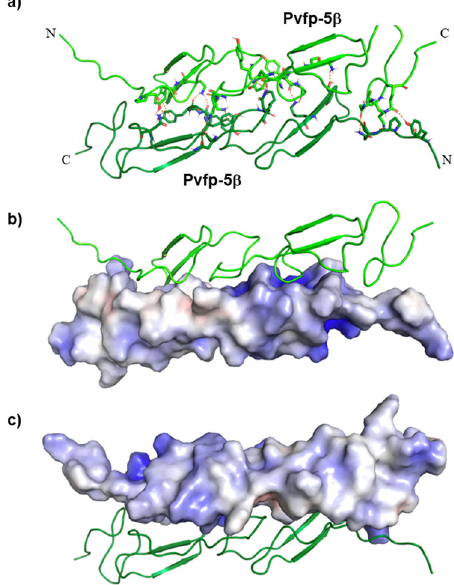
Fig. 4 HADDOCK model of Pvfp-5 β dimer. Lowest energy structure of Pvfp-5 β /Pvfp-5 β dimer as calculated by HADDOCK. a cartoon representation with residues of the two components involved in the interaction showed in sticks. b , c electrostatic surface potential for one monomer and cartoon representation for the other